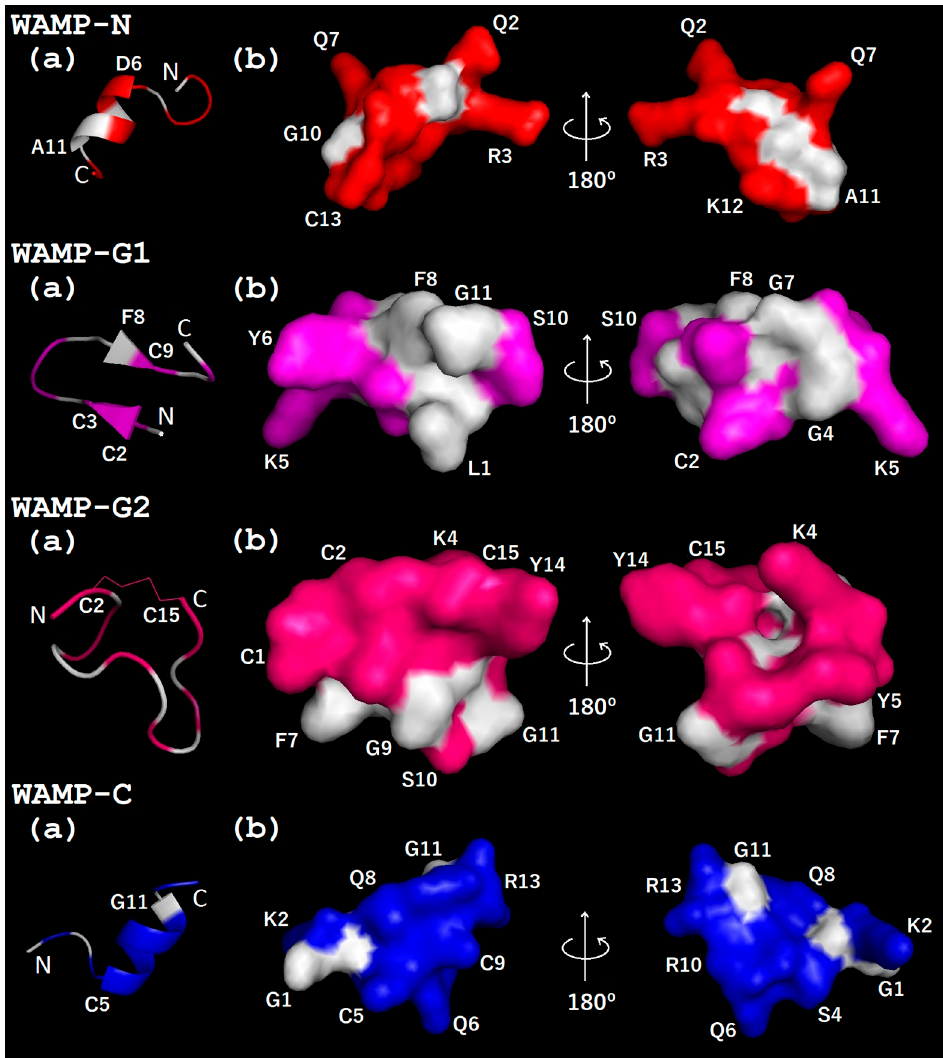
Figure 4. Molecular modeling of the 3D structure of WAMP-2-derived peptides: ( a ) spatial structure (ribbon representation); ( b ) surface structure. A predicted disulphide bond is shown by a thin line. The N- and C-termini are marked with N and C, respectively. Non-polar residues are white, polar residues are colored red, magenta, pink and blue for WAMP-N, WAMP-G1, WAMP-G2 and WAMP-C, respectively. Modeling was carried out using PEP-FOLD 3 [47].